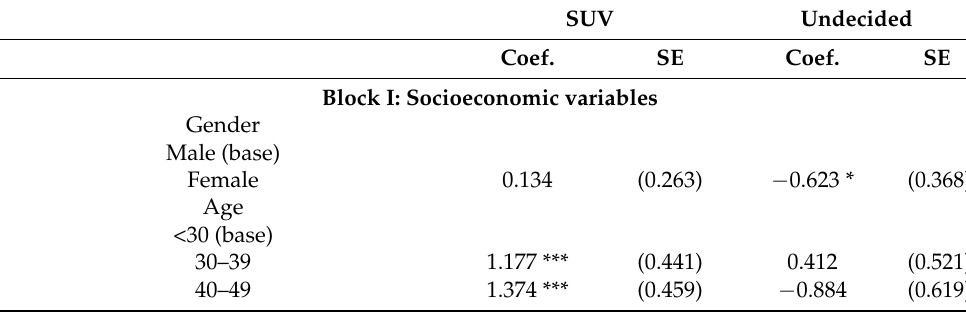
Table 5. Multinomial logistic